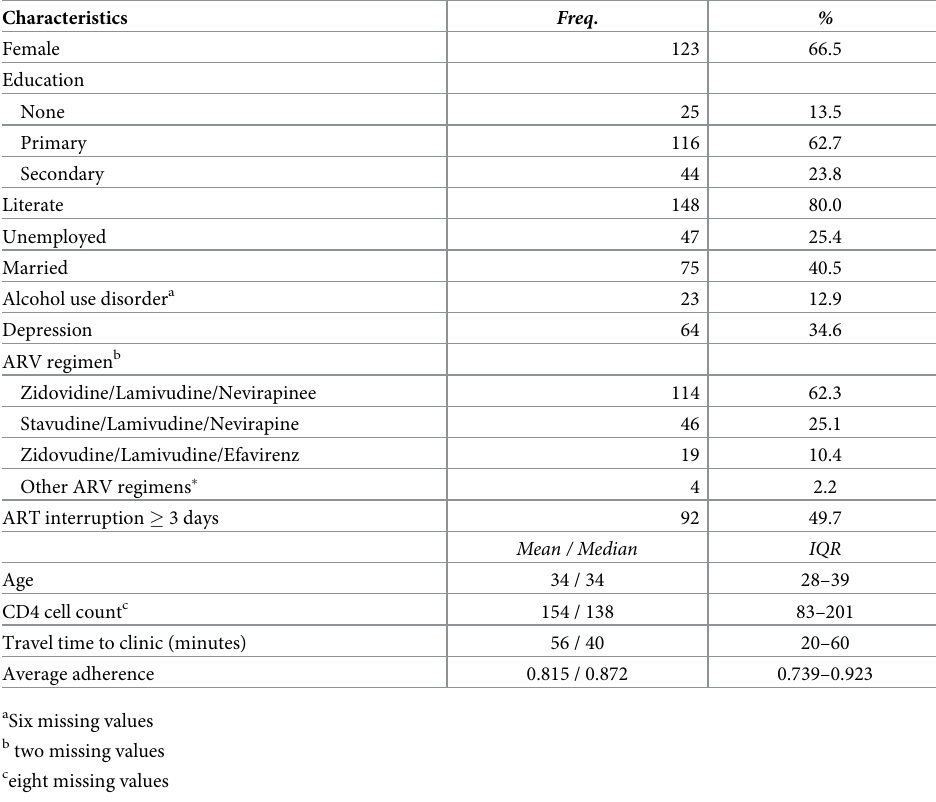
Table 2. Participant characteristics (N =